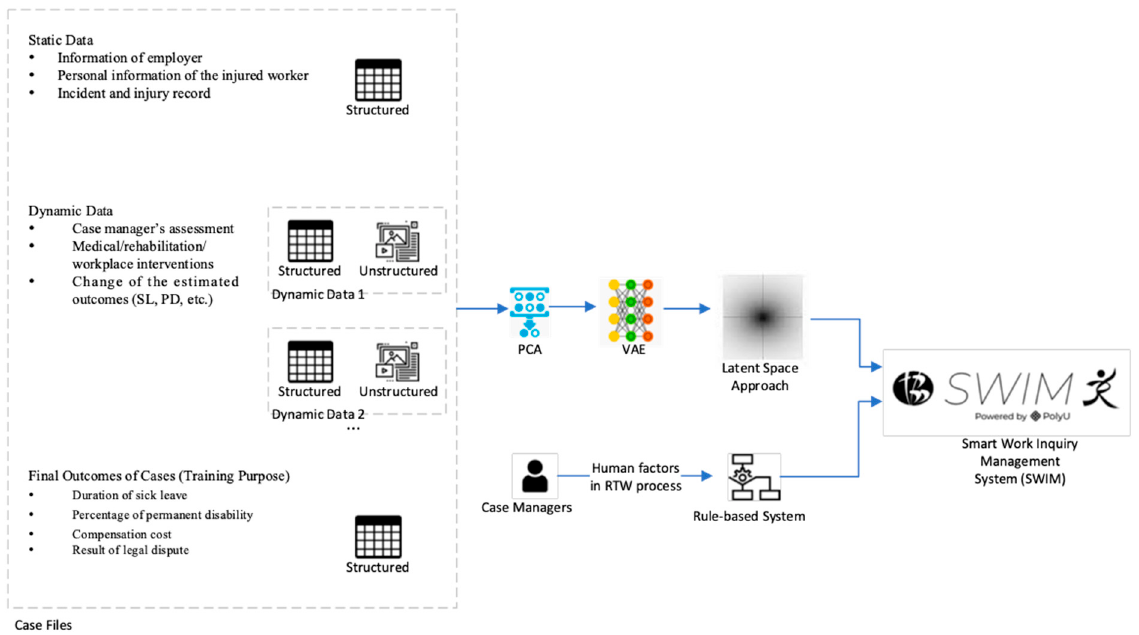
Figure 1. Overview of our current work (SWIM 1.0).